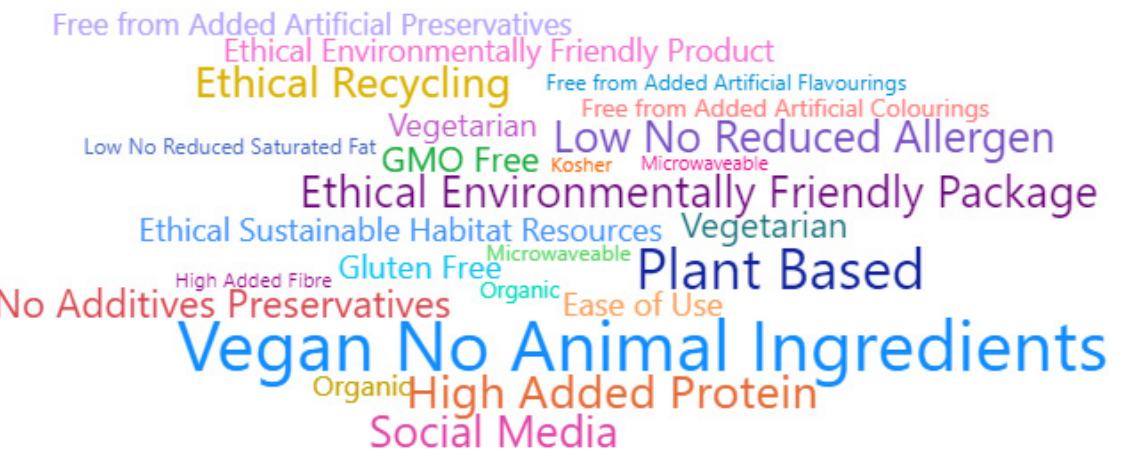
Figure 4. Word cloud of the top 20 claims employed in PBMA products launched over the past three years (2019–2021). Abbreviations: PBMA, plant-based meat alternative. Note: A word cloud is a visual representation of word frequency and value. The “Social Media” claim indicates the presence on the packaging of a logo/claim to entice consumers to join the company’s social media community and follow its channel/website.